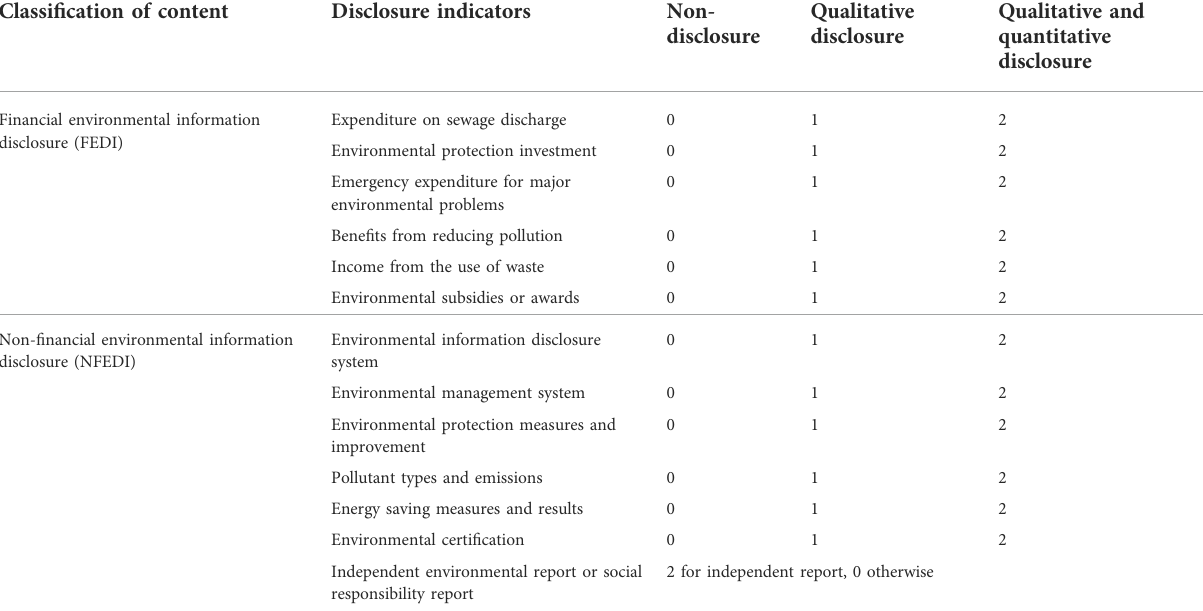
TABLE 1 Environmental information disclosure indicators and scoring